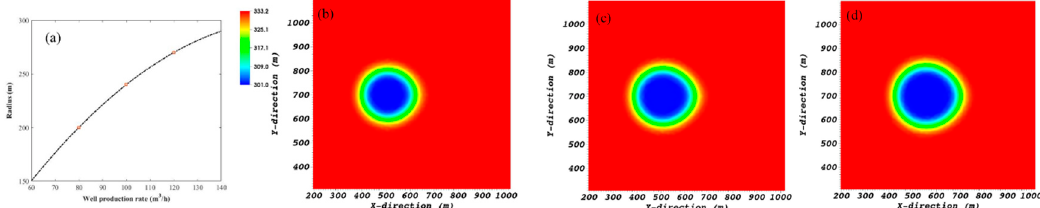
Figure 9. Time evolution of a production well for indirect geothermal district heating systems (IGDHSs) with production rate of 80 m 3 /h: ( a ) temperature at production well; ( b ) pressure at production well.